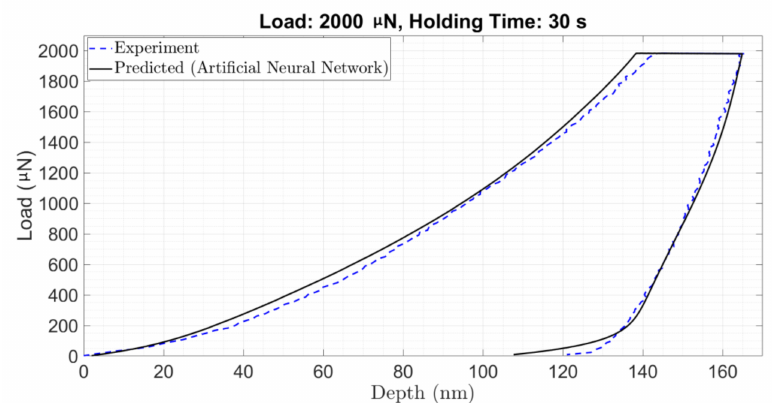
Figure 3. Comparison: experiment vs. predicted for load of 2000 µ N and holding time of 30 s for heat-treated aluminum-based bulk metallic glass (Al-BMG (HT))